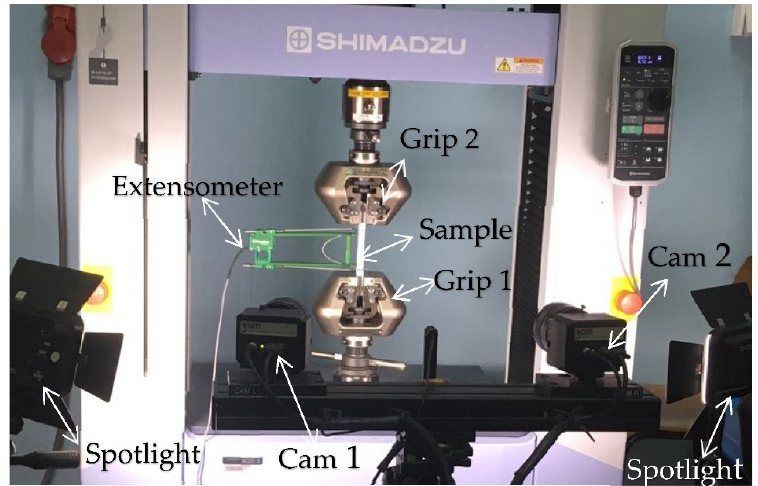
Figure 2. Setting up an experiment with the position of the cameras and with the extensometer set.